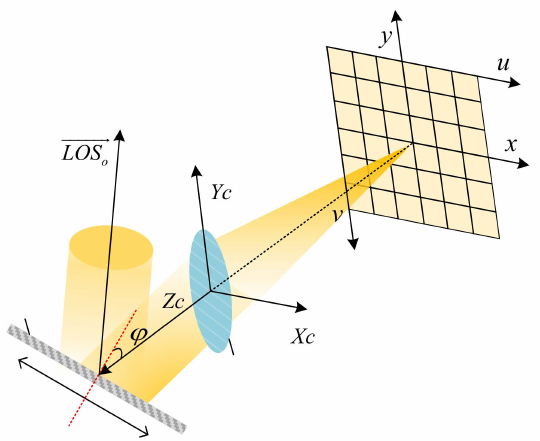
Figure 2. Schematic of the imaging system of camera. N is the normal vector, and ϕ is the intersection angle of the optical axis and the normal of the pointing mirror. is the exit vector corresponding to the principle point of the